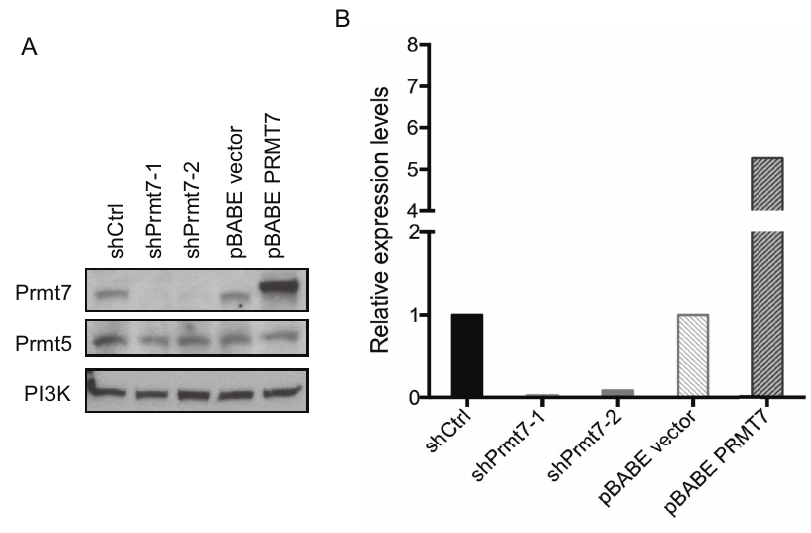
Figure 2. Prmt7 was specifically knocked down or over-expressed in C3H10T1/2 cells. ( A ) A representative Western blot analysis from proliferating C3H10T1/2 cells with Prmt7 knockdown and over-expression. Endogenous Prmt7 was specifically depleted by two different lentiviral shRNA constructs (shPrmt7-1 and shPrmt7-2). The scrambled shRNA lentiviral construct (shCtrl) was used as a control. The pBABE retroviral construct encoding FLAG-tagged PRMT7 (pBABE - PRMT7; 12 ) was used to ectopically express PRMT7, and the pBABE empty vector (pBABE vector) was used as a control. Duplicate blots were probed with anti-Prmt7 and anti-Prmt5 antibodies and with anti-PI3K antibody as a loading control. ( B ) The quantification of Prmt7 in ( A ) by ImageJ. The levels of Prmt7 were normalized to the PI3K loading control and are presented as expression levels relative to the scrambled shRNA control or pBABE empty vector control. The data represent the average of two independent experiments (n=2).